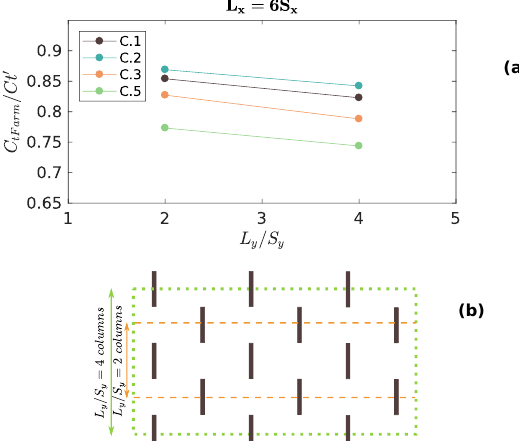
Figure 6. ( a ) variation of C tFarm due to changes in the size of the farm in the spanwise direction, L y . The ratio L y / S y can be interpreted as the number of columns of turbines; ( b ) schematic of the control volumes used for calculating C tFarm for two and four rows of turbines.